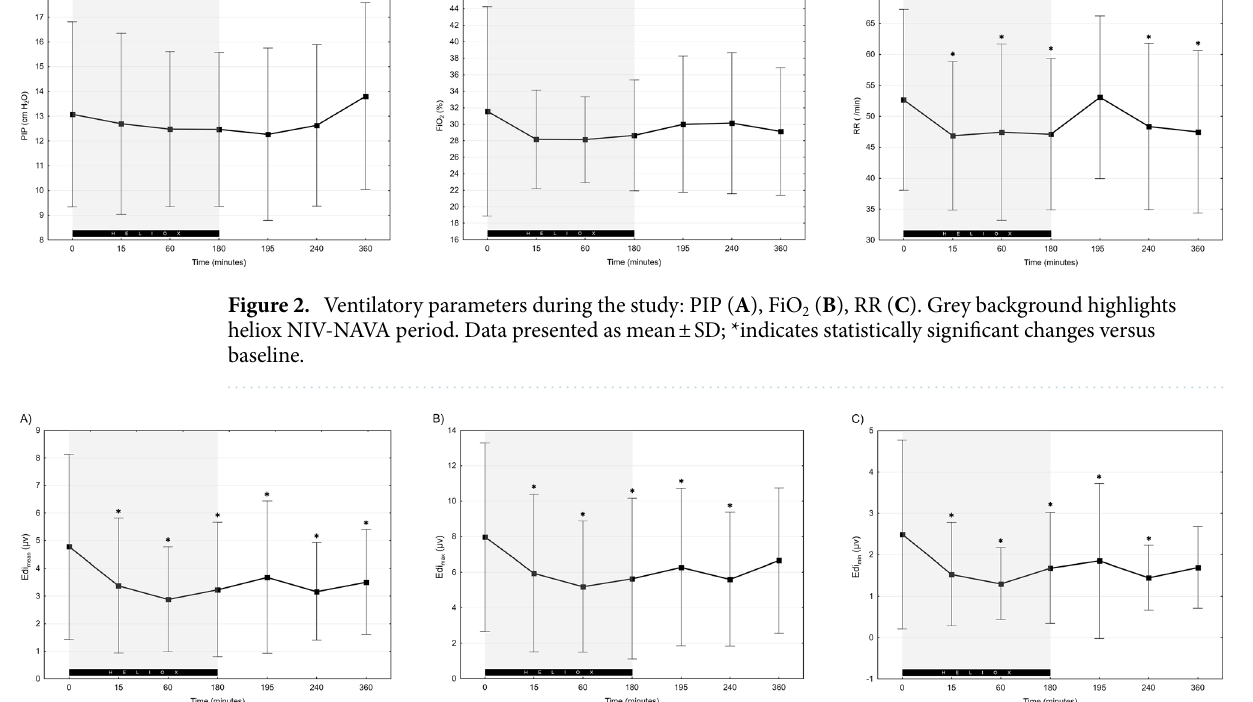
Figure 3. Electrical activity of the diaphragm during the study: Edi mean ( A ), Edi max ( B ), Edi min ( C ). Grey background highlights heliox NIV-NAVA period. Data presented as mean ± SD; *indicates statistically significant changes versus